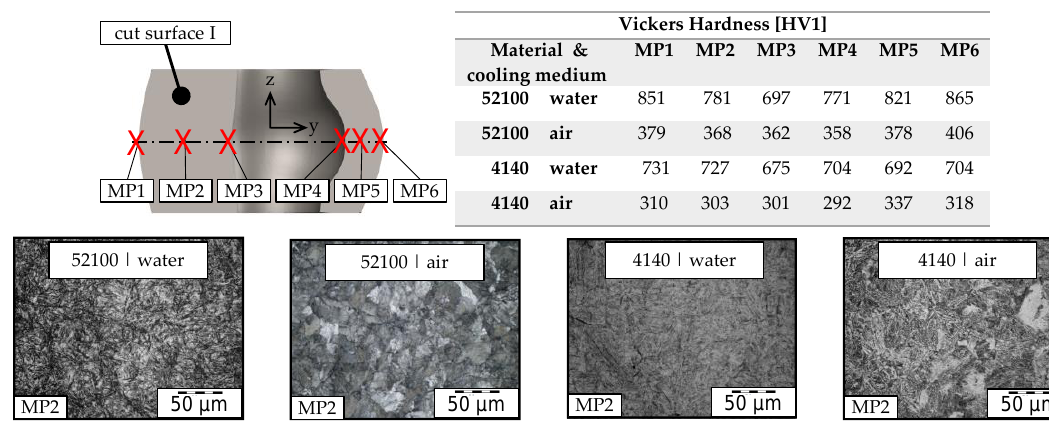
Figure 8. Vickers hardness and micrographs of the resulting microstructures of the differently-treated specimens made of AISI 52100 and AISI 4140.